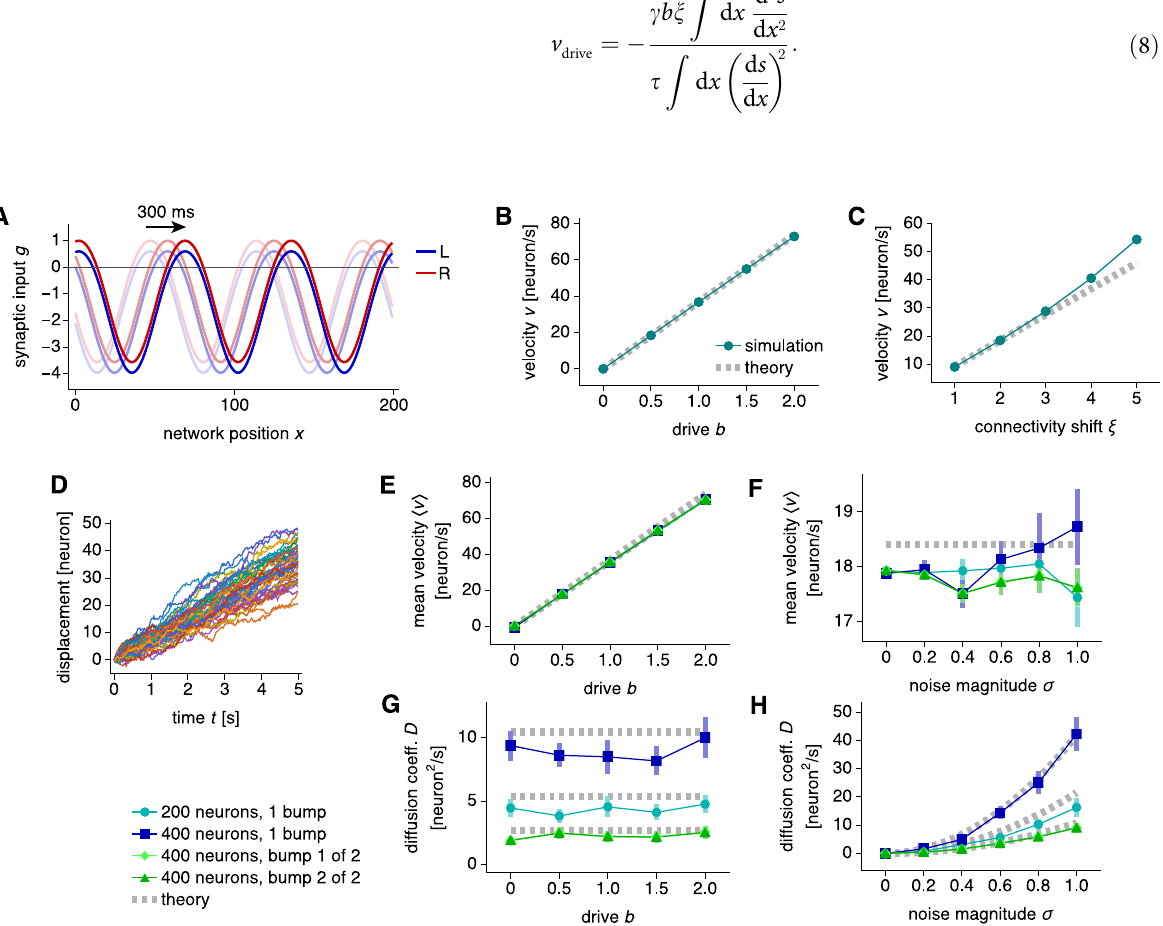
Fig 3. Dynamics in a ring attractor network. ( A – C ) Networks with 200 neurons and 3 bumps. ( A ) Synaptic inputs for populations L and R under drive b = 2. Snapshots taken at 150 ms intervals demonstrate rightward motion. ( B ) Bump velocity is proportional to drive. The connectivity shift is ξ = 2. ( C ) Bump velocity is largely proportional to connectivity shift. The drive is b = 0.5. ( D – H )Networks with synaptic input noise. ( D ) Bump displacements for 48 replicate simulations demonstrating diffusion with respect to coherent motion. Networks with 200 neurons and 1 bump. ( E and F ) Mean bump velocity is proportional to drive and remains largely independent of network size, bump number, and noise magnitude. ( G and H ) Bump diffusion coefficient scales quadratically with noise magnitude, remains largely independent of drive, and varies with network size and bump number. The noise magnitude is σ = 0.5 in D , E , and G , and the drive is b = 0.5 in D , F , and H . Values for both bumps in two-bump networks lie over each other. Points indicate data from 48 replicate simulations and bars indicate bootstrapped standard deviations. Dotted gray lines indicate Eqs 8 and